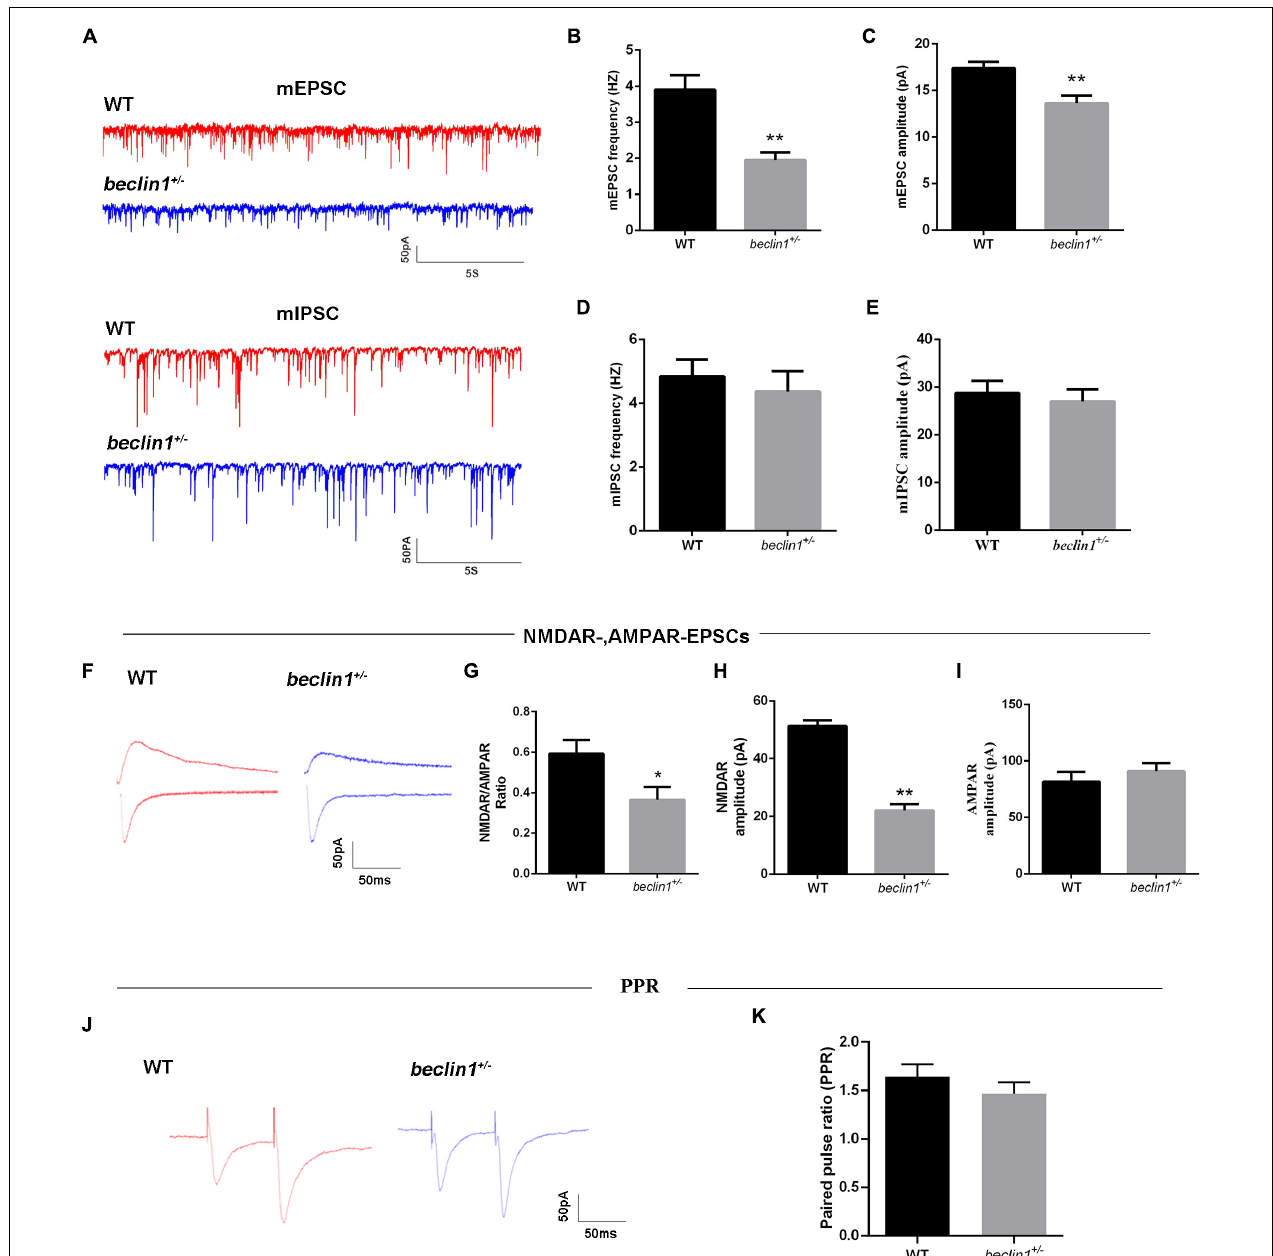
FIGURE 4 | Knockdown of beclin1 affected excitatory synaptic transmission. (A) Representative traces of mEPSCs and miniature inhibitory postsynaptic currents (mIPSCs) from the two groups. (B,C) Quantitative analysis of the frequency and amplitude of the mEPSCs [wild-type (WT) group: n = 10, beclin1 ± group: n = 8]. (D,E) Quantitative analysis of the frequency and amplitude of the mIPSCs ( n = 12 per group). (F) Representative traces of NMDAR-mediated and AMPAR-mediated EPSCs from the two groups. (G–I) Summary of the EPSC amplitude from the two groups ( n = 6 per group). (J) Representative traces of the paired-pulse ratios (PPRs) for AMPA-mediated EPSCs at three different interstimulus intervals. (K) Summary of the PPRs between the two groups ( n = 6 per group). Data are presented as the means ± SEM. * p < 0.05 and ** p < 0.01. Student’s t -tests were performed.